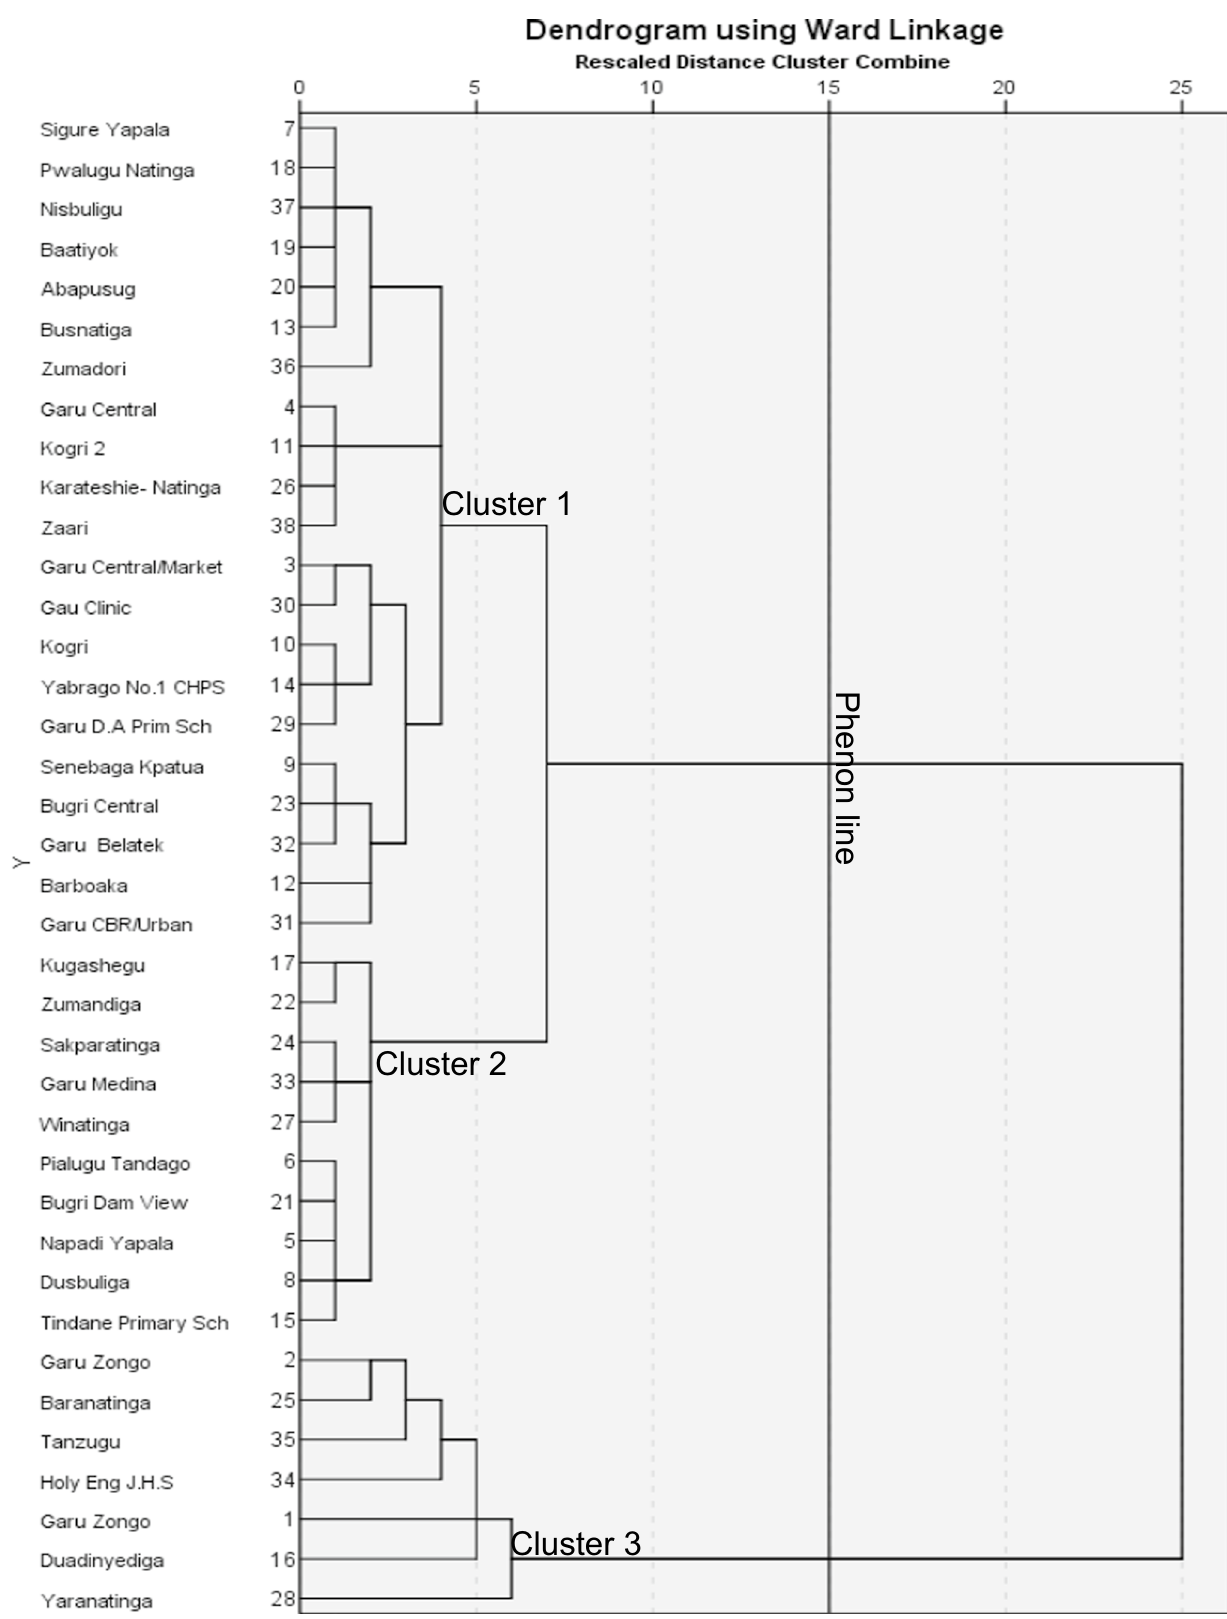
Fig. 6 Dendrogram showing Q-mode